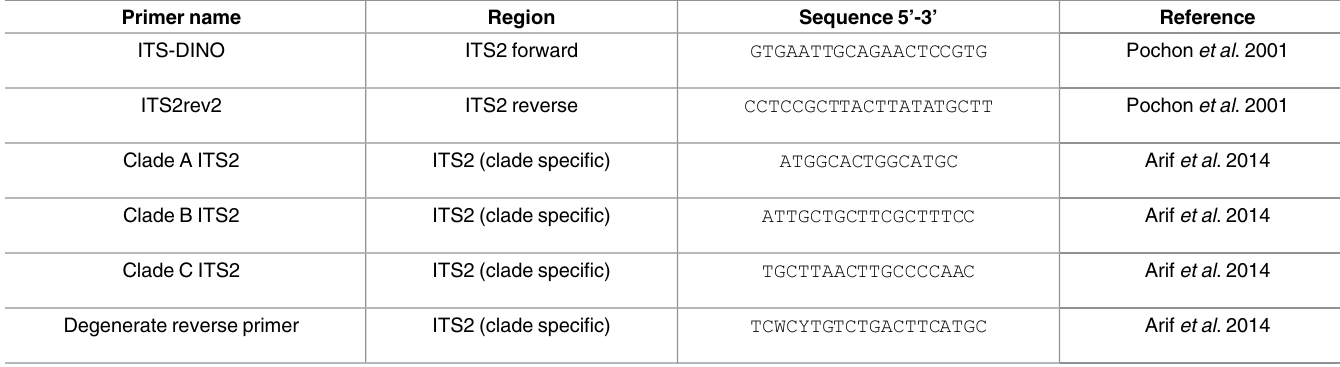
(Table 1; [48]), 1 μL 10 mM ITS2rev2 (Table 1; [48]), 0.625 μL dNTP (10 mM each; New Table 1. PCR primers used in this